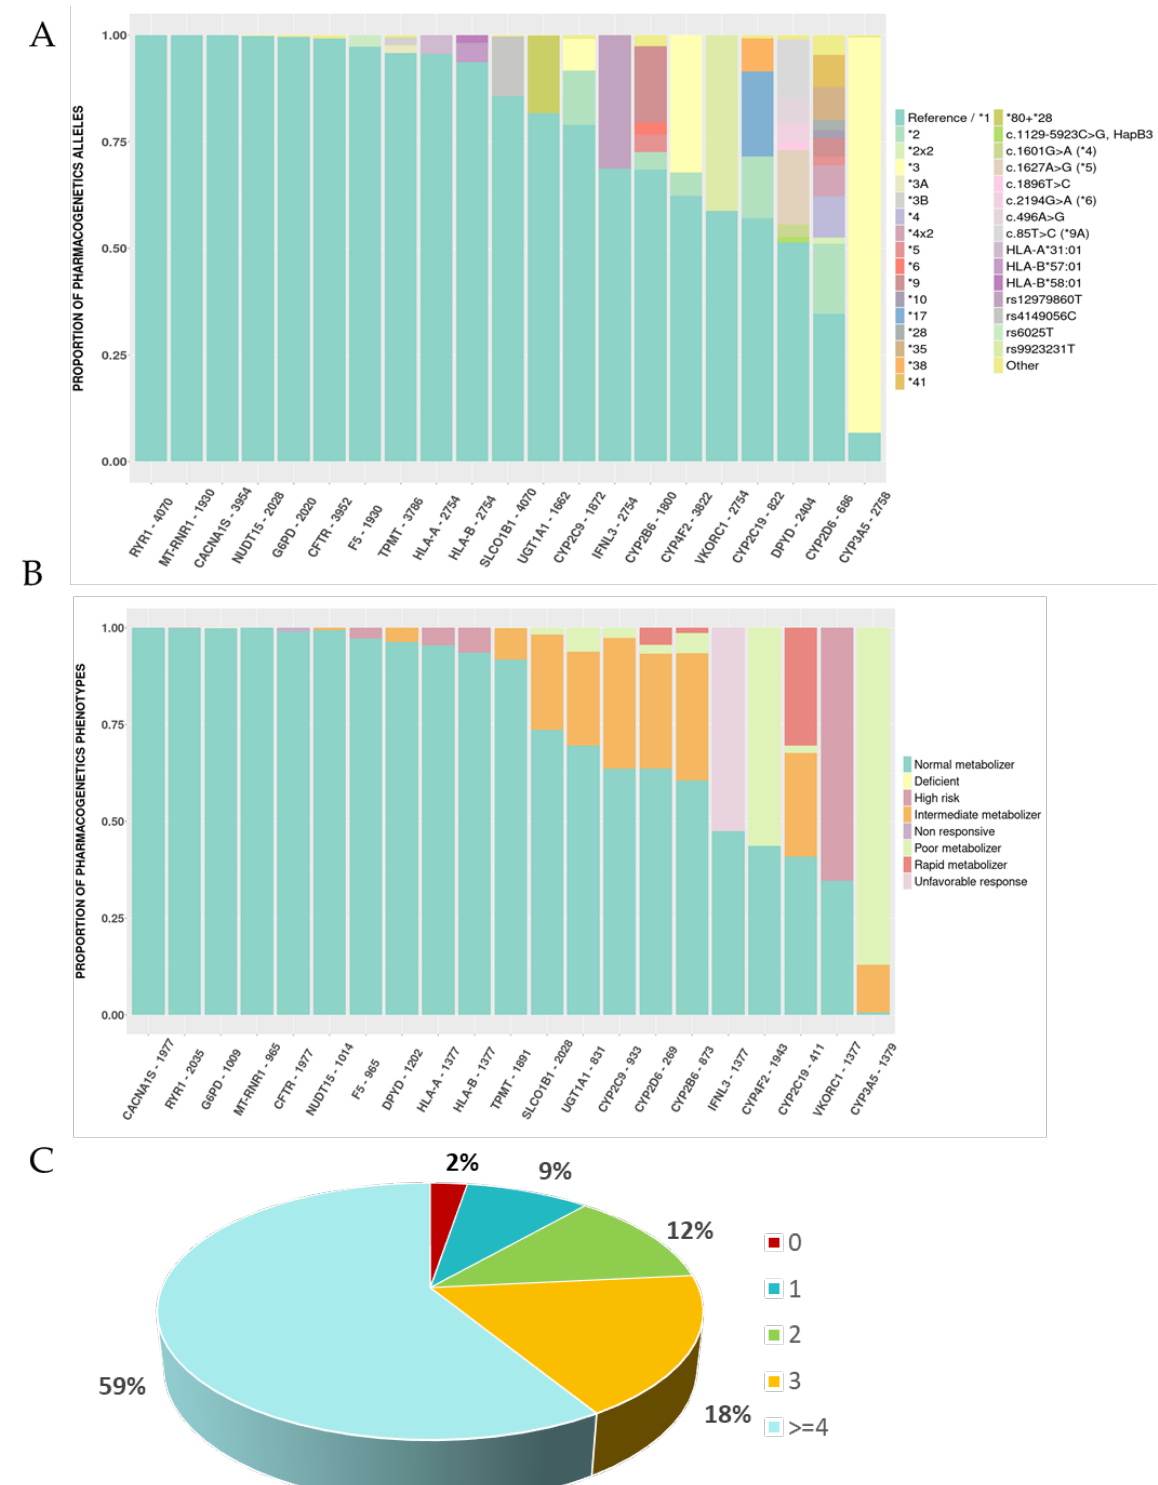
Figure 1. Pharmacogenetic genotype and phenotype proportions of the Spanish population for the main 21 pharmacogenetic (PGx) genes. ( A ) Proportion of the different PGx alleles (star (*) alleles) or variants for each of the 21 genes with the highest PGx levels of evidence (1A) and associated with the CPIC clinical guidelines identified in the Spanish population. Those alleles identified in <1% of